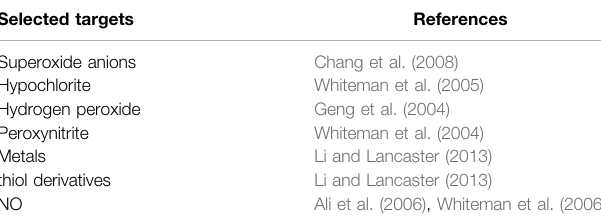
TABLE 2 | Selected targets of